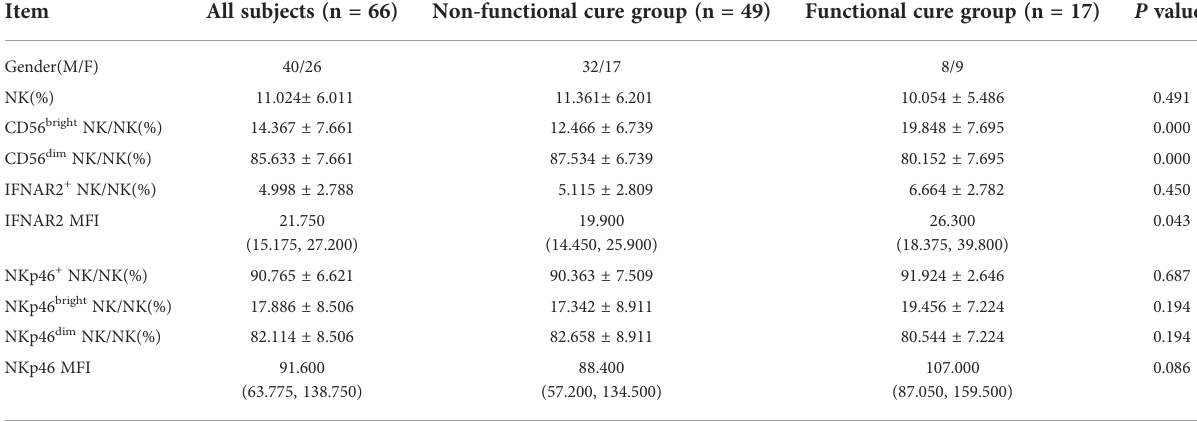
TABLE 2 and surface receptors NKp46 and INFAR2 expression of NK cells at baseline between functional cure group and non-functional cure group. Item All subjects (n =